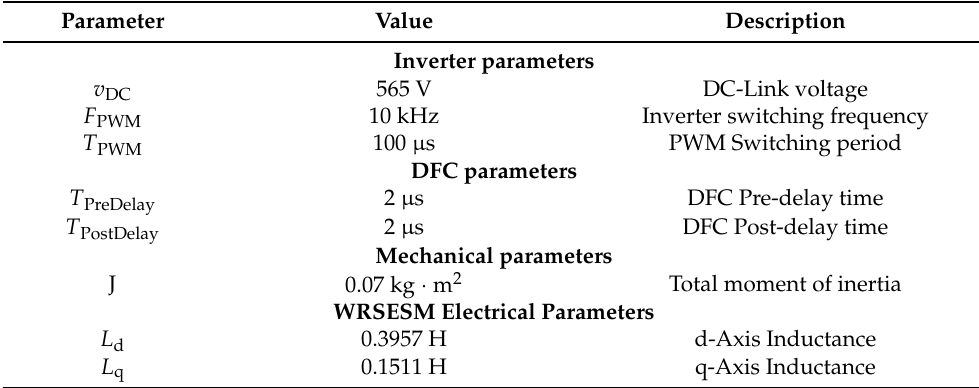
Table 3. Sensorless speed control with DFC—Simulation